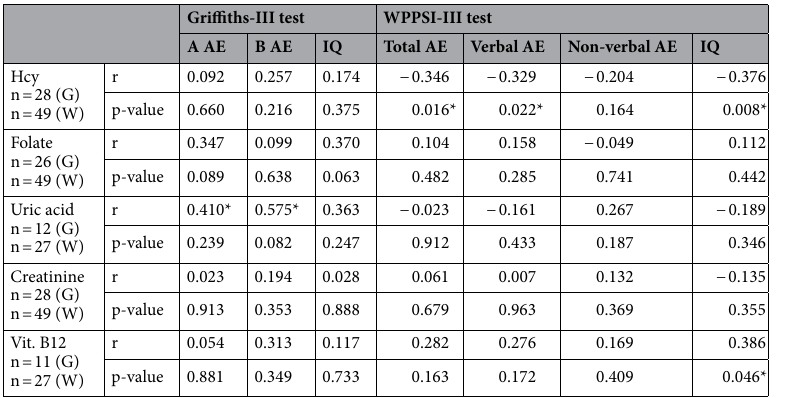
Table 2. Correlation between metabolite levels and Griffiths-III or WPPSI-III test scores. Partial correlations (r) correct by age was done between Griffiths-III or WPPSI-III subtest scores and metabolite levels; bivariate correlations (r) were done between IQ scores and metabolite levels. Correlation between vitamin B12 (Vit. B12)/UA levels and Griffiths-III or WPPSI-III test scores was analyzed only in fasting subjects. The analysis includes outliers. Further analysis after outlier exclusion is described in the text. AE age equivalent, A evaluation of “foundations of learning”, B evaluation of “language and communication”, IQ intelligence quotient, (G) number of subjects with Griffiths-III test scores, (W) number of subjects with WPPSI-III test scores. *p-value ≤ 0.05 or moderate correlation 0.4 < r < 0.7.